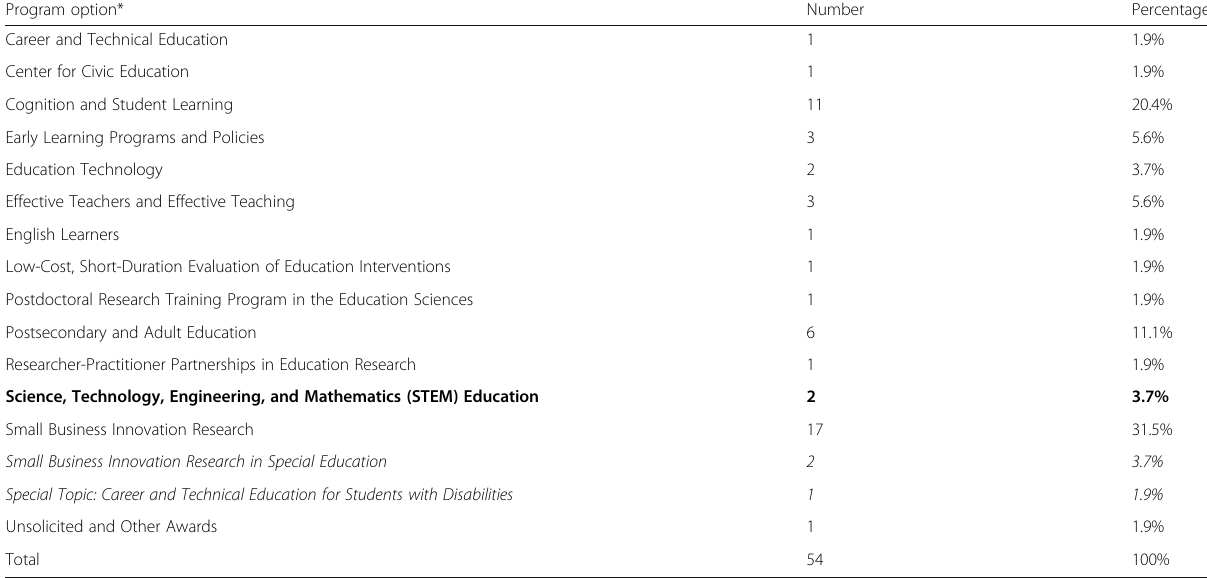
Table 1 The distribution of projects containing the acronym “ STEM ” from 2007 to 2019 across program